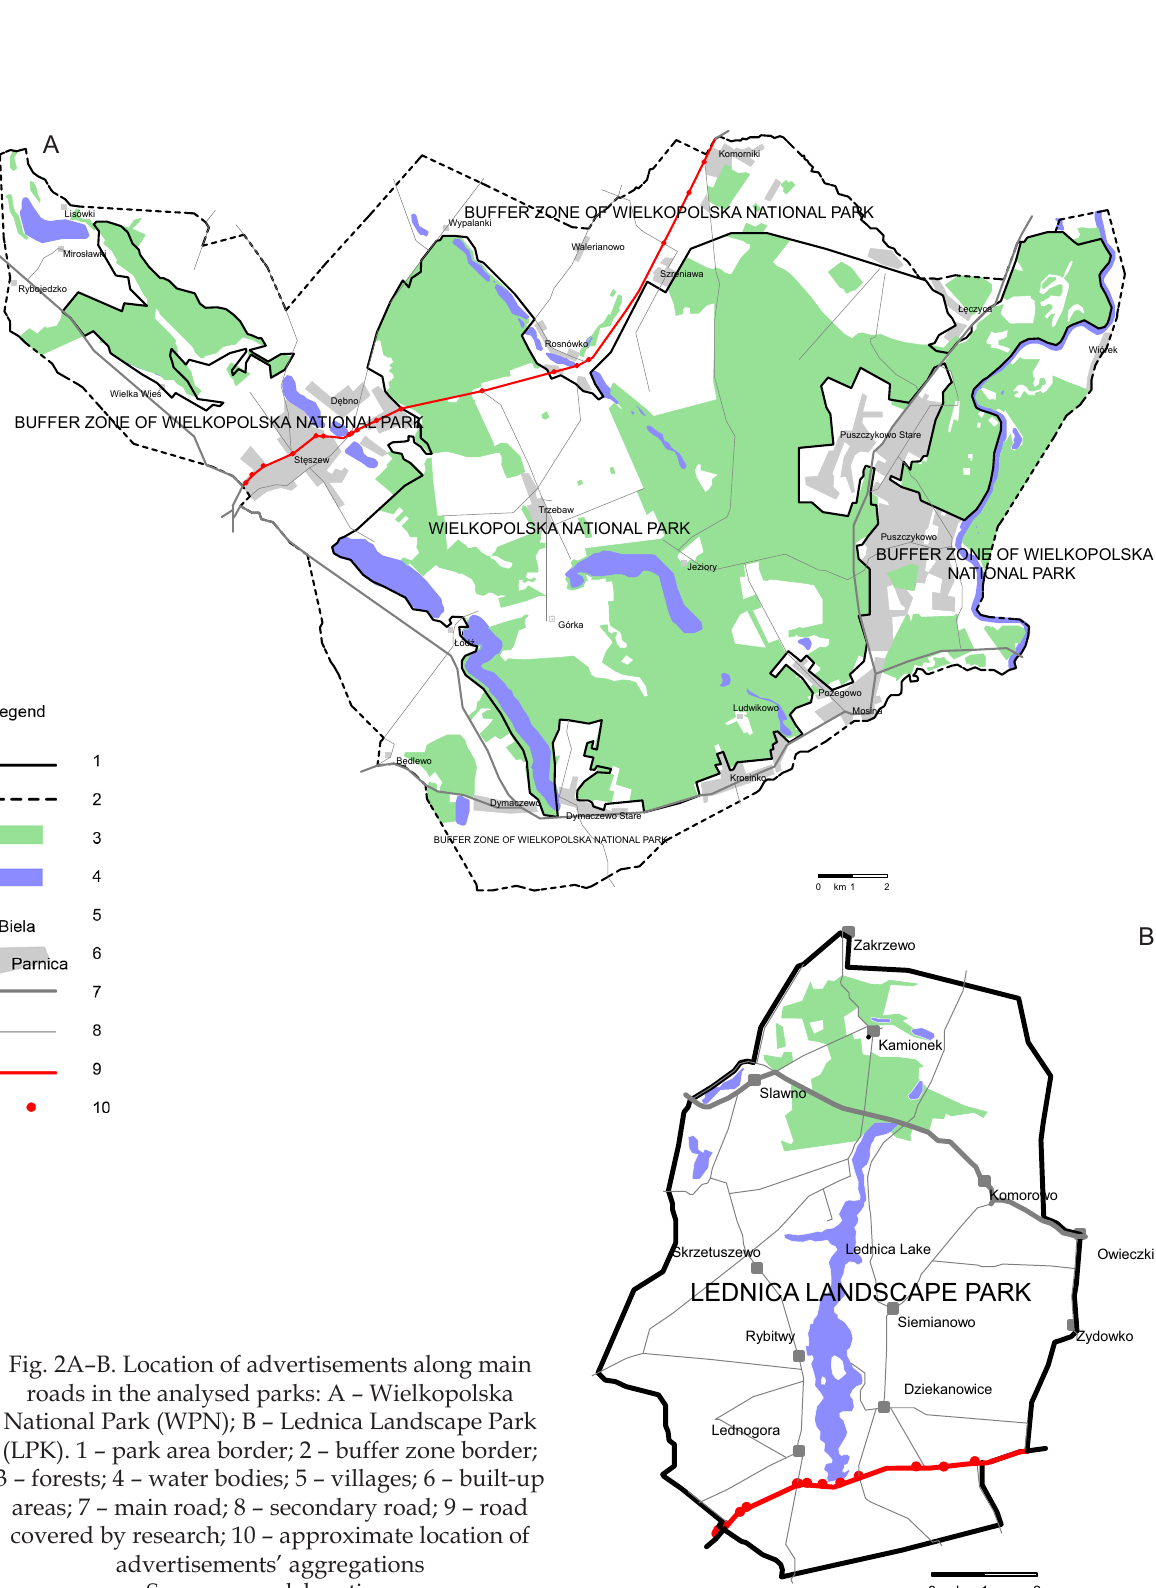
Fig. 2A–B. Location of advertisements along main roads in the analysed parks: A – Wielkopolska National Park (WPN); B – Lednica Landscape Park (LPK). 1 – park area border; 2 – buffer zone border; 3 – forests; 4 – water bodies; 5 – villages; 6 – built-up areas; 7 – main road; 8 – secondary road; 9 – road covered by research; 10 – approximate location of advertisements’ aggregations Source: own